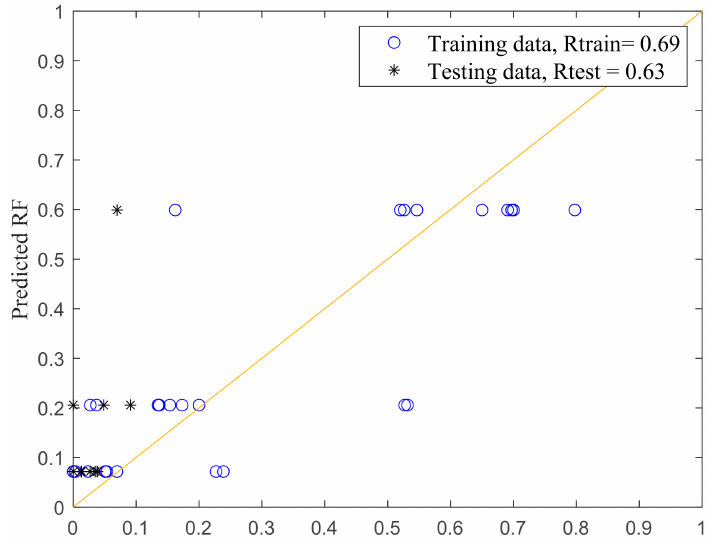
Figure 5. Predicted RF from DT and actual RF from experiments for oil/brine